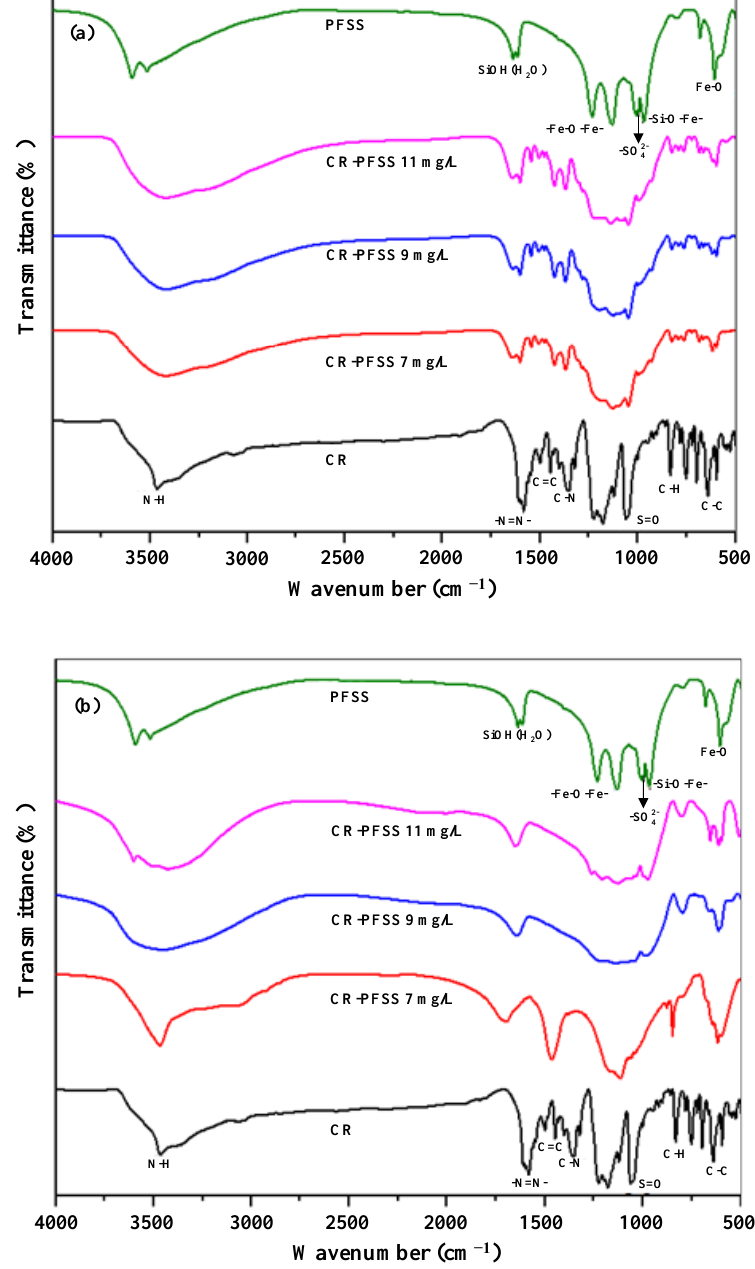
Figure 4. FTIR spectra of PFSS before and after degradation of diazo Congo red dye at: ( a ) pH 5; ( b ) pH 11.